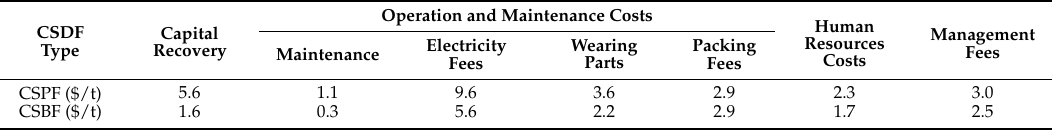
Table 3. Calculated cost of CSDF production ( i = 0.08 and n =